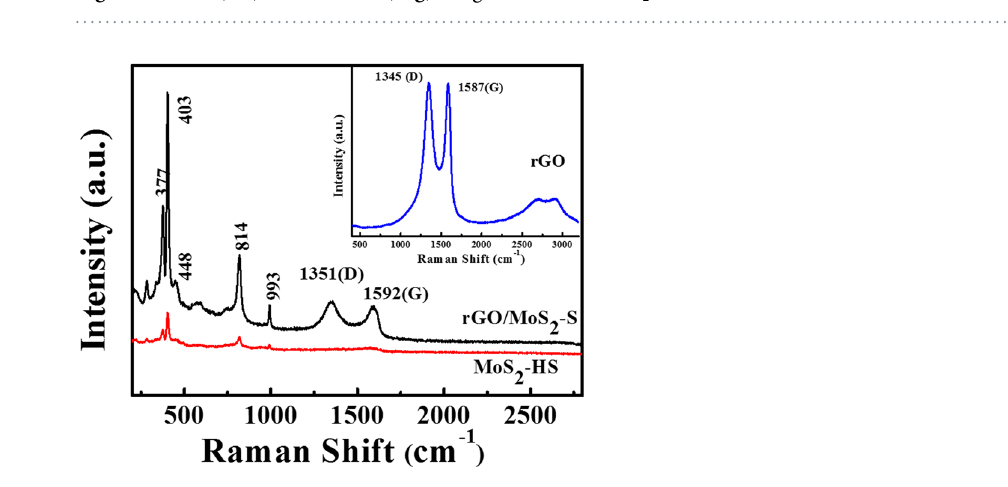
Figure 4. SEM ( a , b ) and HRTEM ( c – g ) image of the rGO/MoS 2 -S.